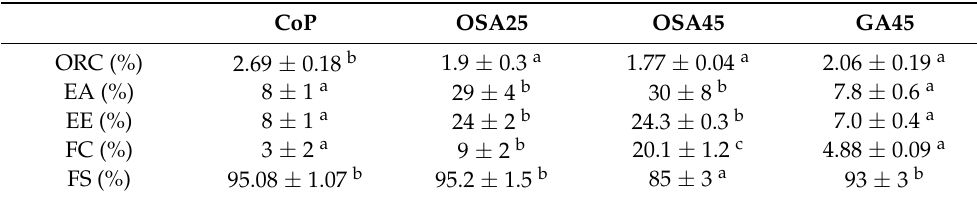
Results are expressed as mean ± standard deviation. Different letters in superscripts ( a–c ) indicate significant differences among samples for each property ( p <